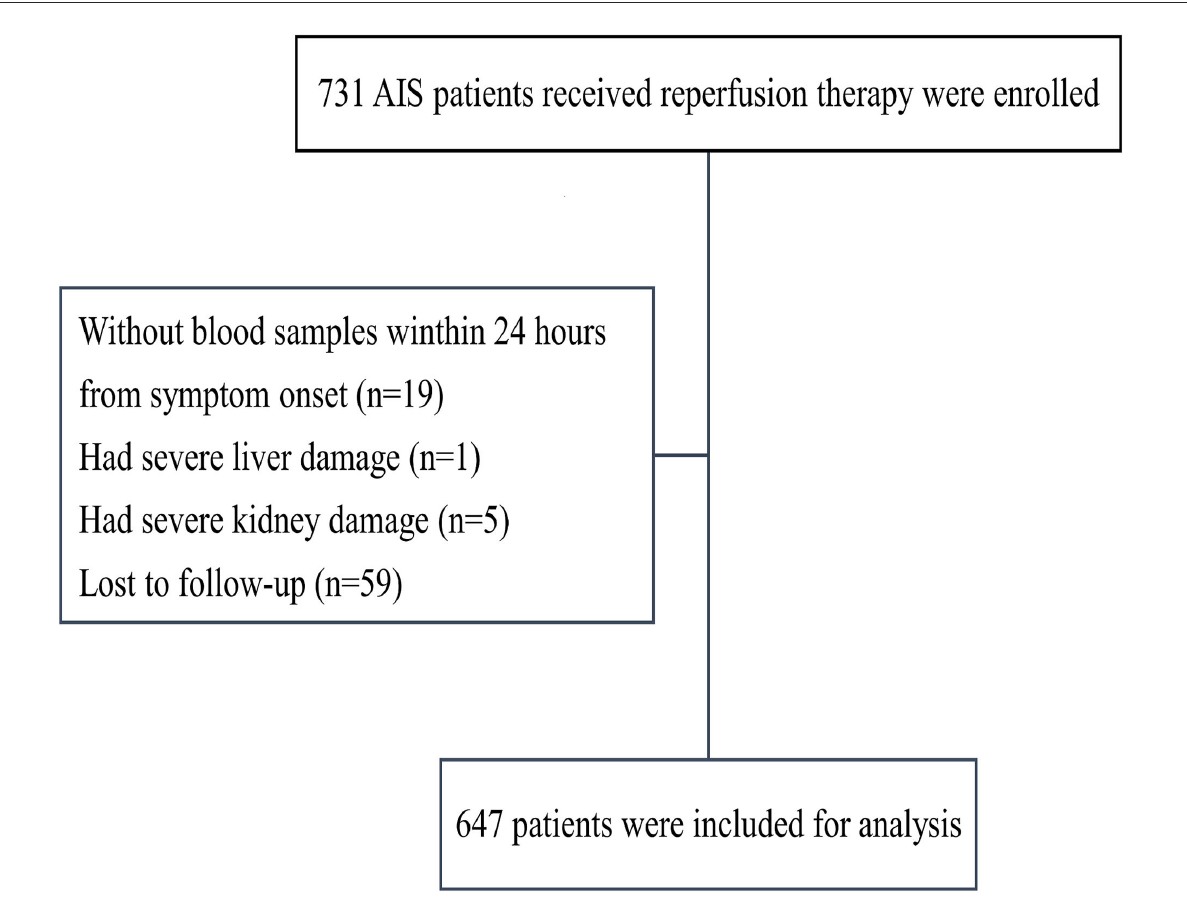
FIGURE1 A flowchart of patient